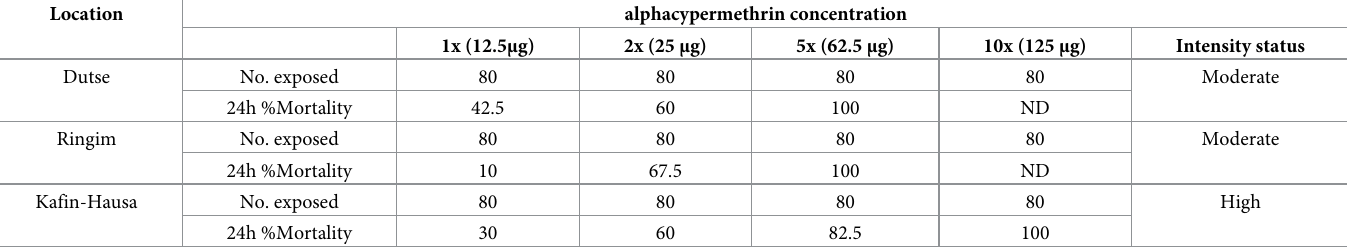
Table 5. Resistance intensity status of Culex quinquefasciatus after 24-hr post exposure to 1x, 2x, 5x and 10x of diagnostic concentration of alphacypermethrin in CDC bottle bioassay. Location alphacypermethrin concentration Dutse No. exposed Ringim No.